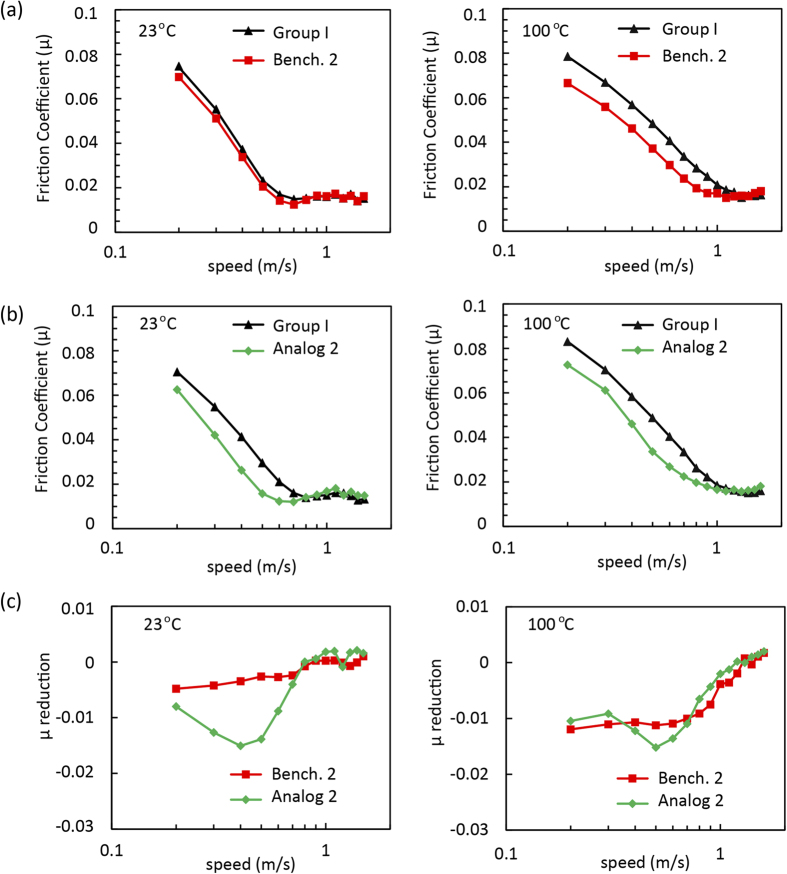
The Stribeck curves of (a) Bench.2 (1.67 wt %) and (b) analog 2 (2 wt %) at 23 °C and 100 °C. (c) The reduction in friction coefficient achieved by subtracting the base oil friction.